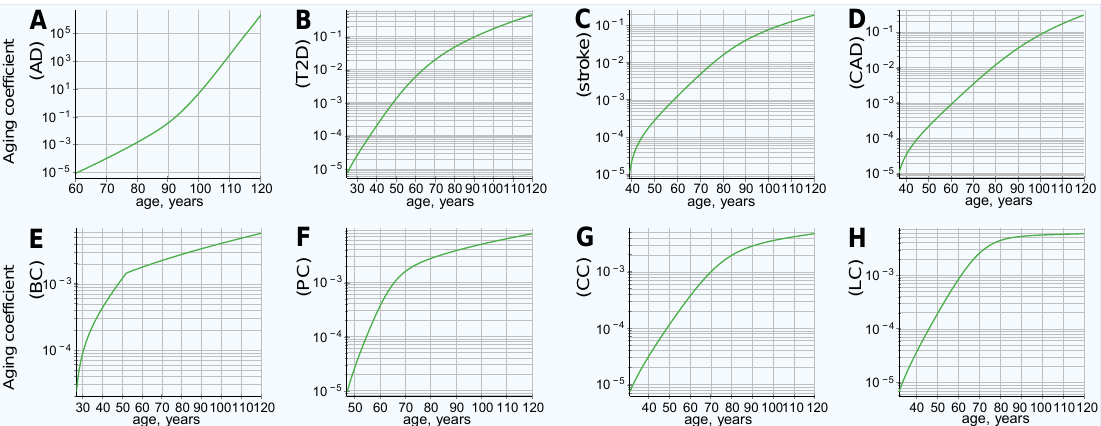
Figure 1. Aging coefficients reflect increases in late-onset disease (LOD) liability with age, based on the clinical incidence rate and model genetic architecture polygenic risk score (PRS). ( A ) Alzheimer’s disease (AD), ( B ) type 2 diabetes (T2D), ( C ) cerebral stroke, ( D ) coronary artery disease (CAD), ( E ) breast cancer, ( F ) prostate cancer, ( G ) colorectal cancer, and ( H ) lung